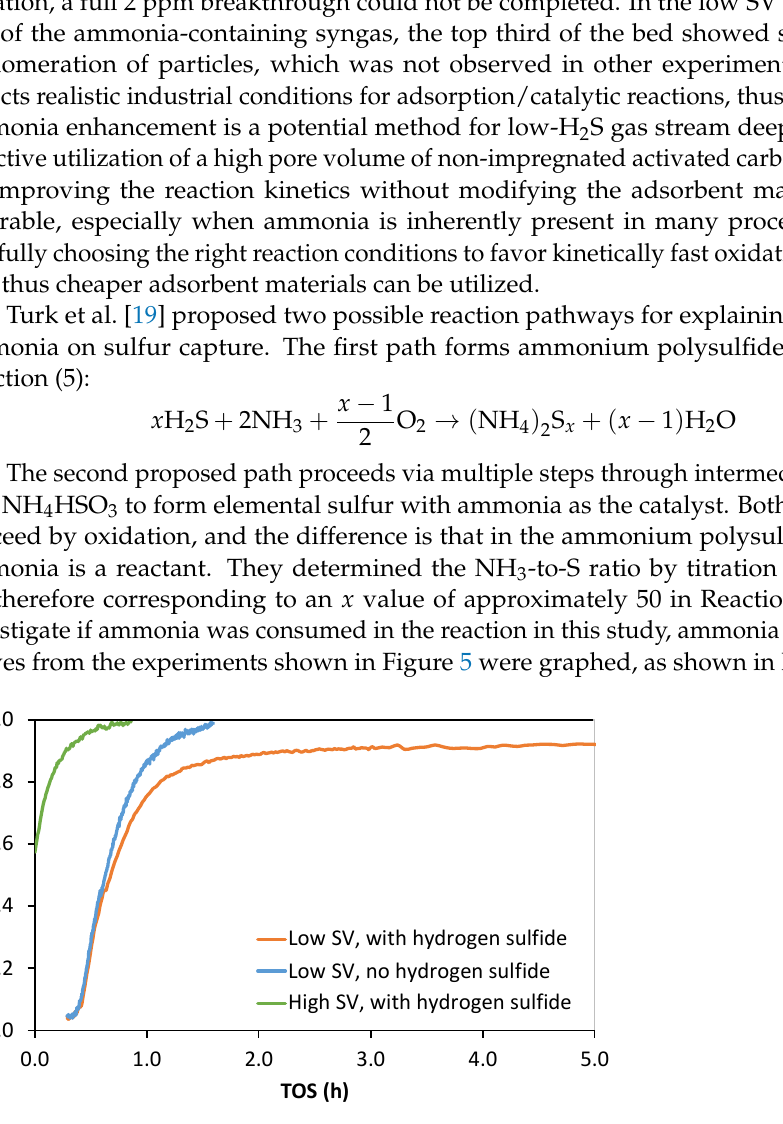
Figure 7. Characterization of fresh and spent AC1 from experiments with and without ammonia in syngas as presented in Figure 5b. ( a ) Thermogravimetric analysis (TGA) in N 2 . Percentage weight change derivative (weight loss) as a function of temperature. ( b ) Pore volume change as a function of pore width. In Figure 7a thermal analysis of the spent sample from the experiment with ammonia shows between 200 and 450 °C (maximum at 290 °C) weight loss above the fresh adsorbent baseline, which is attributed to sulfur vaporization. The baseline subtracted weight loss equals ca. 12% sulfur loading in the sample. The breakthrough test bed mass increased 31%, which is agreement with the theoretical sulfur mass flow during the experiment. This indicates that some of the bound sulfur was not released in the range 125–500 °C. The sample from the experiment without ammonia only shows a slightly elevated weight loss